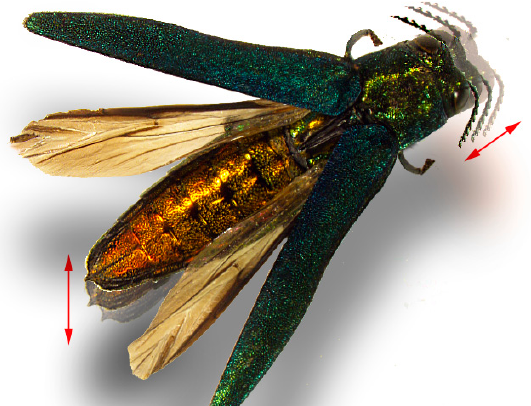
Figure 2. Representation of a male A. planipennis undertaking sound-producing behavior (wing opening / head pumping). Arrows indicate direction of movement for both abdomens. (vertically) and head (horizontally) [16].